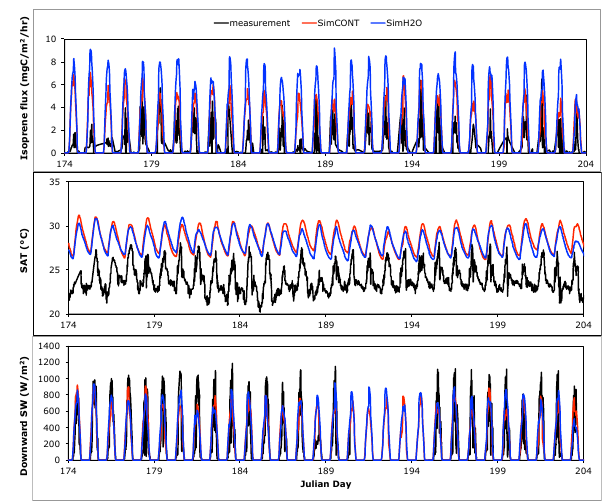
Fig. 7d. (a–f) Time evolution of isoprene emission flux, surface air temperature (SAT) and downward shortwave (SW) radiation at Figure 7d. Results for dry season Santarem during October 22 – November 6 2003. the tropical measurement sites. Measurements are shown in black (where data is available). Model climatological results are averages of 10 simulation years in SimCONT (red) and SimH2O (blue). (d) dry season Santarem during 22 October–6 November 2003.